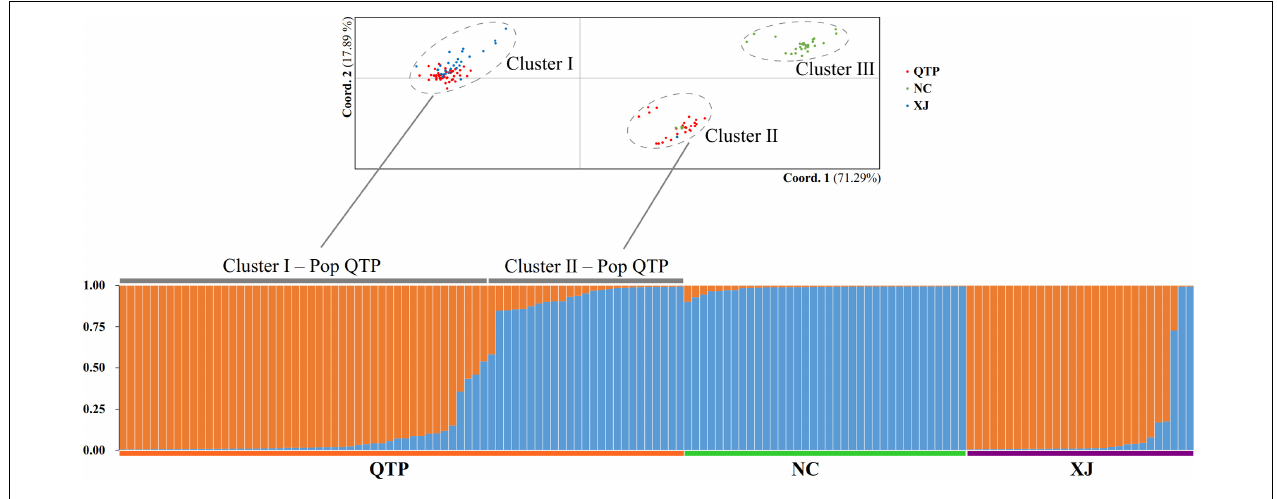
FIGURE 1 | cpSSR genetic structure and principal component cluster